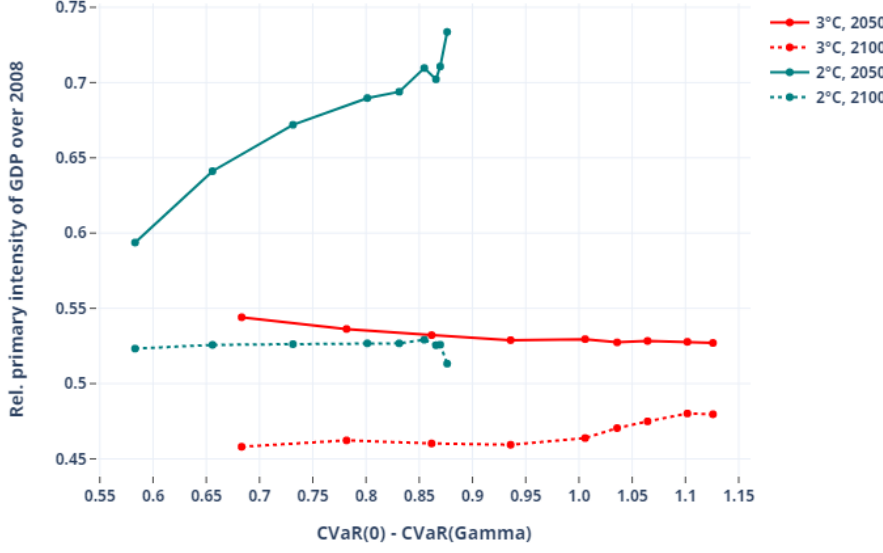
Figure 6. Primary energy intensity of GDP against protection level. The evolution of these two intensities reflects very different strategies for the 3 ◦ C and 2 ◦ C constraints. Hedging against climate uncertainty at the 3 ◦ C level shows a balanced use of energy efficiency and decarbonization of primary energy in 2050; the two indicators show comparable reduction levels (more or less 50%) compared to the 2008 reference. In 2100, the 3 ◦ C scenario hedges with a stronger reduction of carbon intensity, at the expense of primary energy intensity: carbon intensity drops with hedging ( − 50% to − 60%) while energy intensity remains quite flat ( − 45% to − 47%). This is especially true for higher protection levels for which CCS massively penetrates the decarbonization mix (see below). This yields negative carbon intensities, indicating negative net